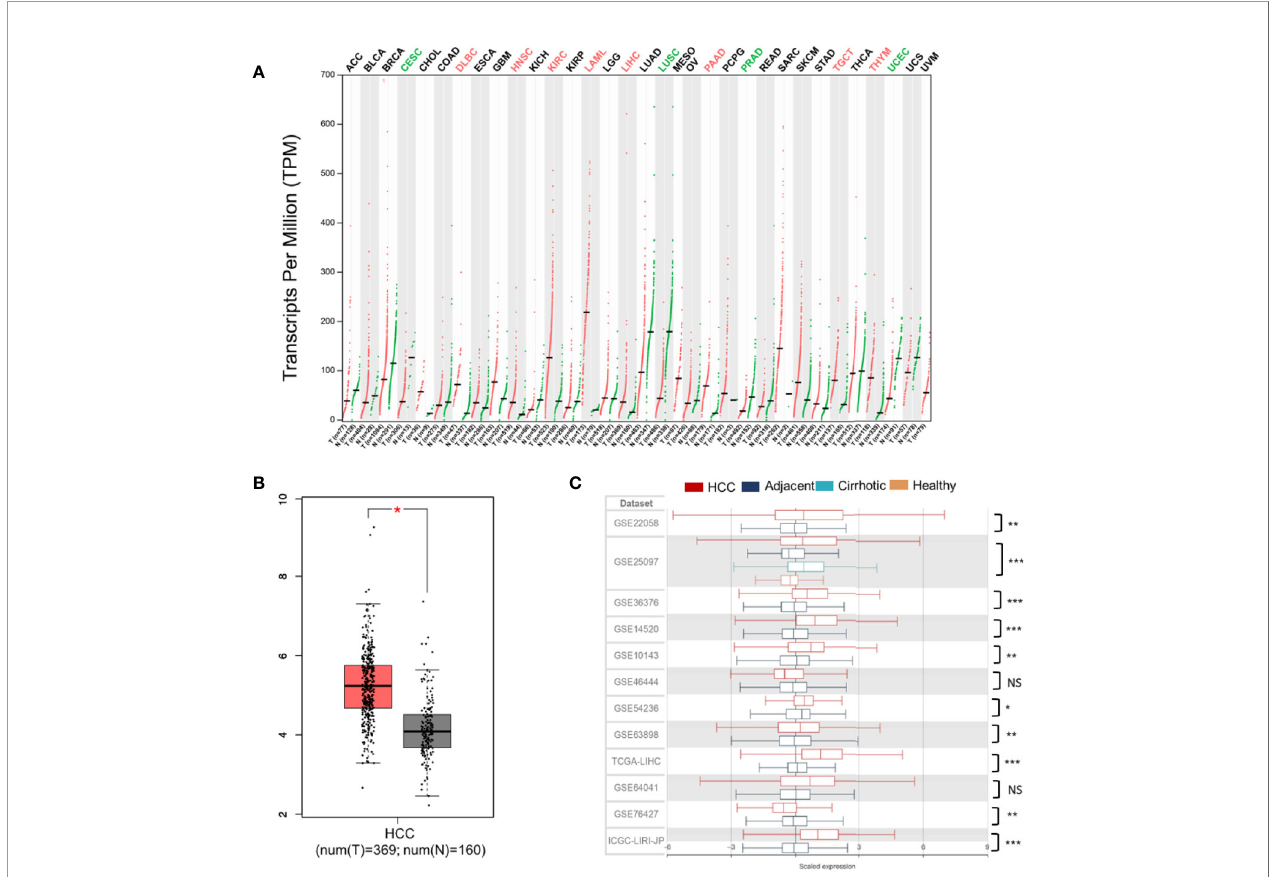
FIGURE 1 | PLXND1 mRNA expression is elevated in hepatocellular carcinoma (HCC). (A) The expression of PLXND1 varied among different tissues and tumors across TCGA cancer types from Gene Expression Pro fi ling Interactive Analysis (GEPIA), and the difference was signi fi cant in liver hepatocellular carcinoma (LIHC). (B) PLXND1 expression in HCC tissues was greater than normal tissues from GEPIA. (C) PLXND1 expression in 10 out of 12 clinical cohorts was signi fi cantly elevated in HCC tissues compared to the adjacent tissues. Twelve clinical cohorts contain both HCCs and the adjacent normal liver tissues. Only GSE25097 dataset contains tissues (tumor and adjacent non-tumor) from HCCs plus cirrhotic tissues and normal liver tissues. HCC, hepatocellular carcinoma; *P < 0.05, **P < 0.01 and ***P < 0.001; NS, not signi fi